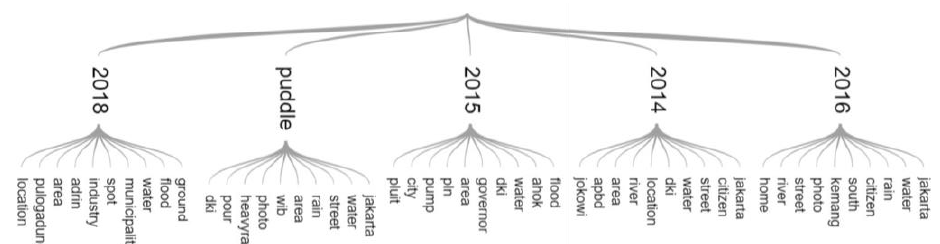
Figure 12. Taxonomy generated (translated) by topic similarity metric from seed root node (topic tag) “banjir_jakarta” (jakarta_flood). The leaf nodes are the top words of their respective parent topic. The generated tree is limited to the 5 most similar topics.